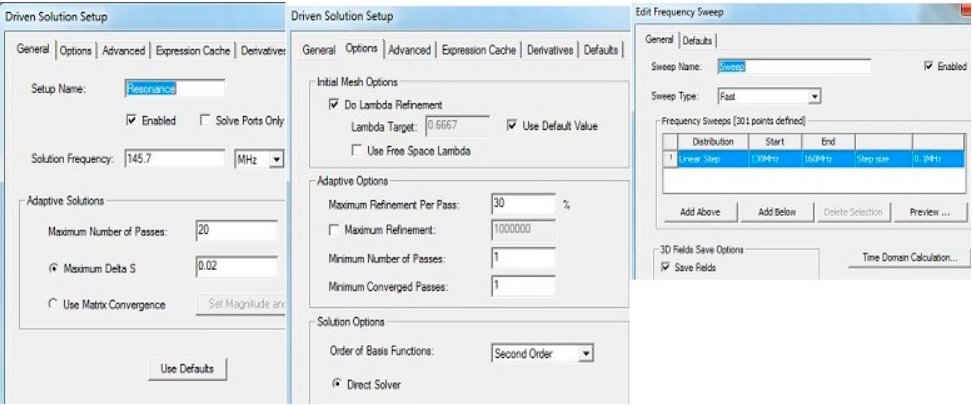
Figure A3. Driven solution setup and its frequency sweep.